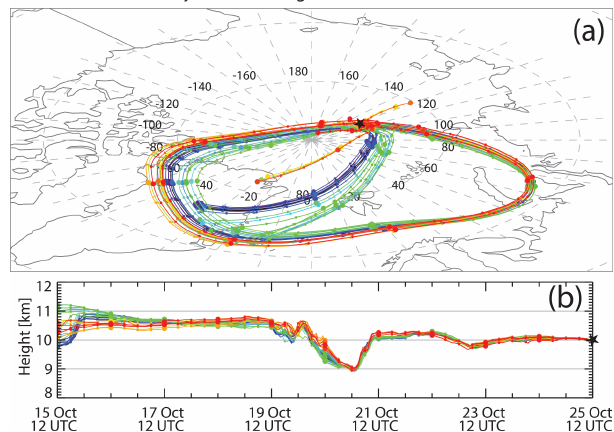
Figure 10. HYSPLIT 10d ensemble backward trajectories arriv- ing at 10km height above RV Polarstern (black star) on 25 Octo- ber 2019 at 12:00UTC (HYSPLIT, 2021). Thin and thick symbols indicate 6 and 24h time steps, respectively. Colours are used to bet- ter identify different subgroups of